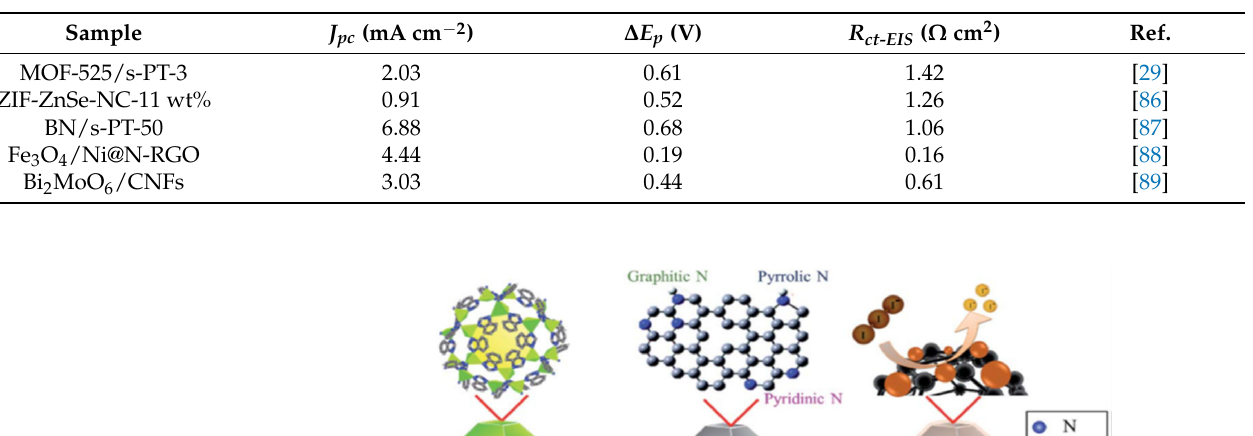
Table 8. The electrochemical parameters of various hybrid compound electrocatalysts measured in the I − /I 3 − -based electrolyte.